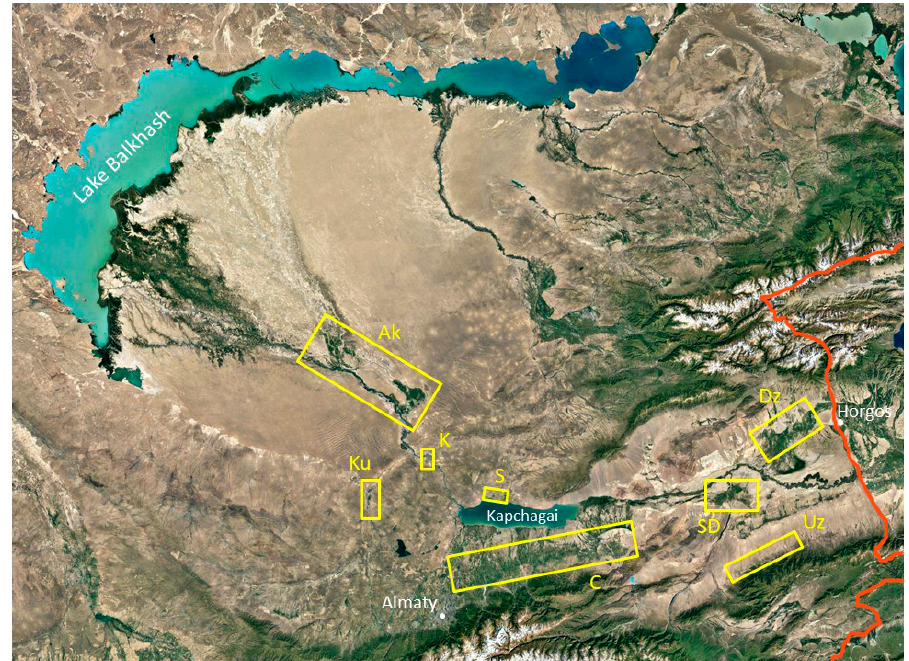
Figure 6. Locations of irrigation sites in the lower Ili basin of Kazakhstan: (Ak), Akdala; (C), Chilik River/Trans Ili Alatau; (Dz), Dzungarian Alatau; (K), Kurbulak; (Ku) Kurty River; (S), Shengeldy; (SD), Sharyn River delta; (Uz), Uzynkara. The orange line marks the border with China.